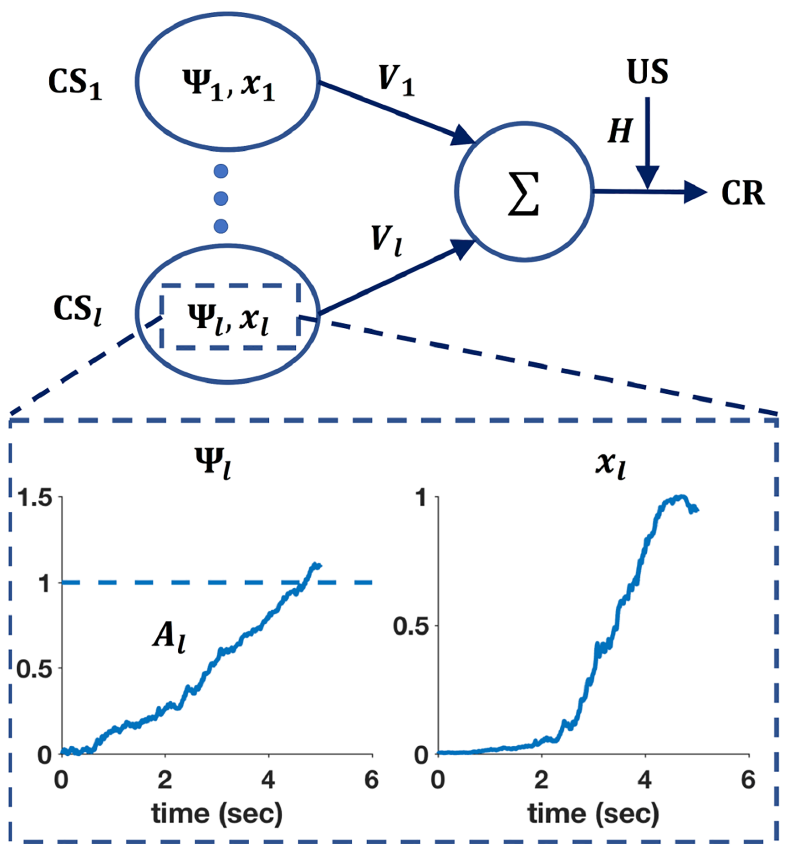
Fig 1. Connectionist diagram of RWDDM. Each CS unit is connected to a summing junction(labelled Σ ) via a modifiable link V . The output of the summing junction is the CR. The US is representedas a teaching signal with a fixed weight H . Each CS unit has its own timer Ψ and representation x . The bottom panelshows a zoomed-in view of the timer Ψ l and CS representation x l associatedwith CS l . The timer slope A l is tuned to a 5-secondCS